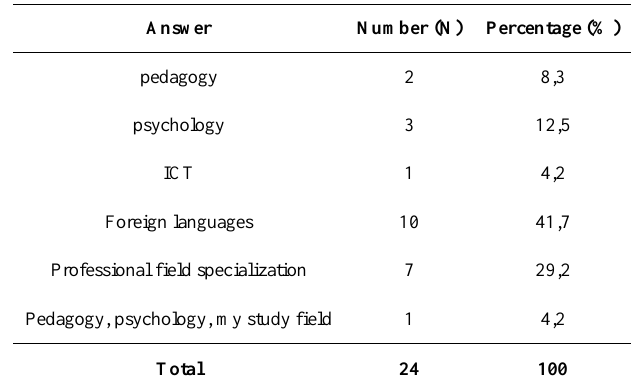
Table 3. Areas of interest for furthering